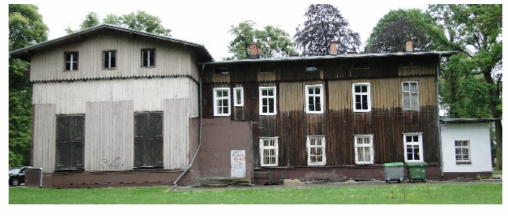
Figure 15. Casino south elevation.